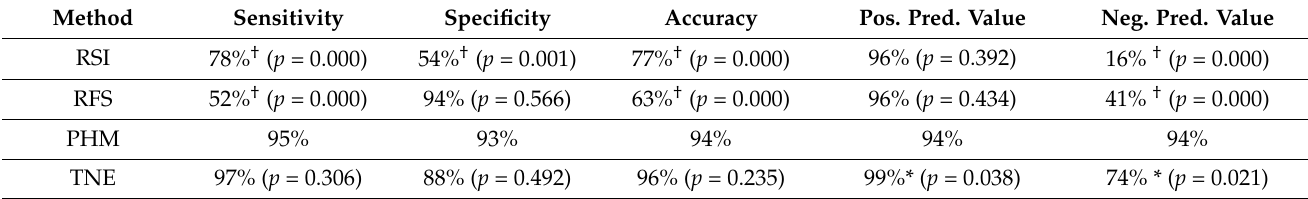
Table 4. Detection of laryngopharyngeal reflux ( n =